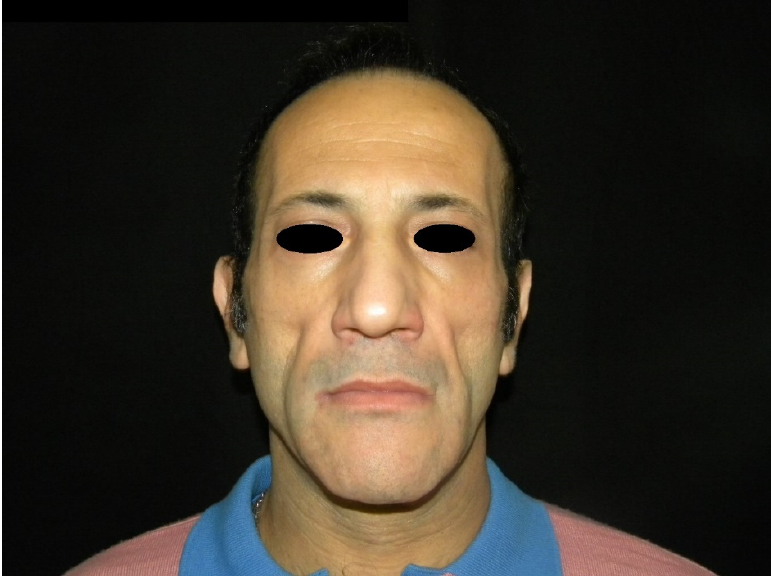
Figure 1. Preoperative frontal view of a patient presenting facial lipoatrophy.